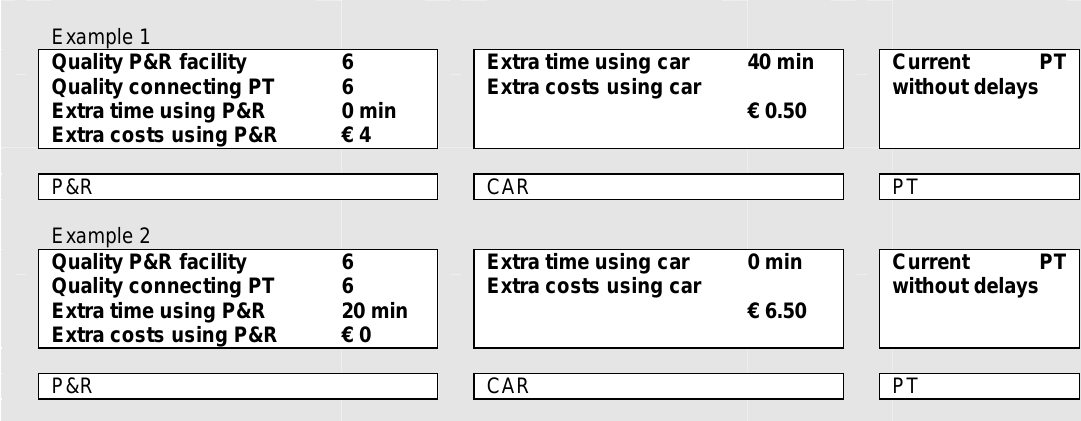
Figure 1. Examples of choice